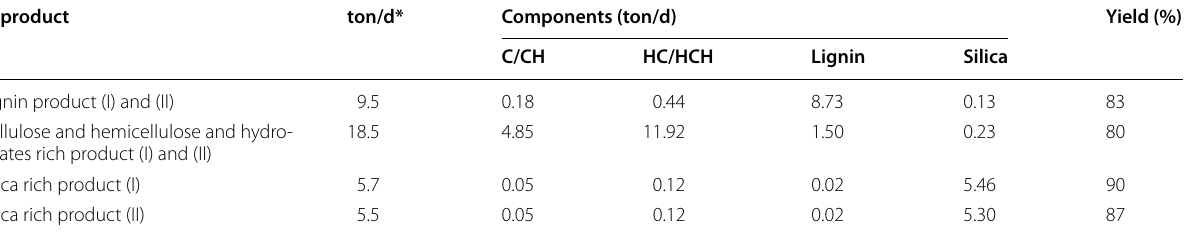
*Dry weight basis